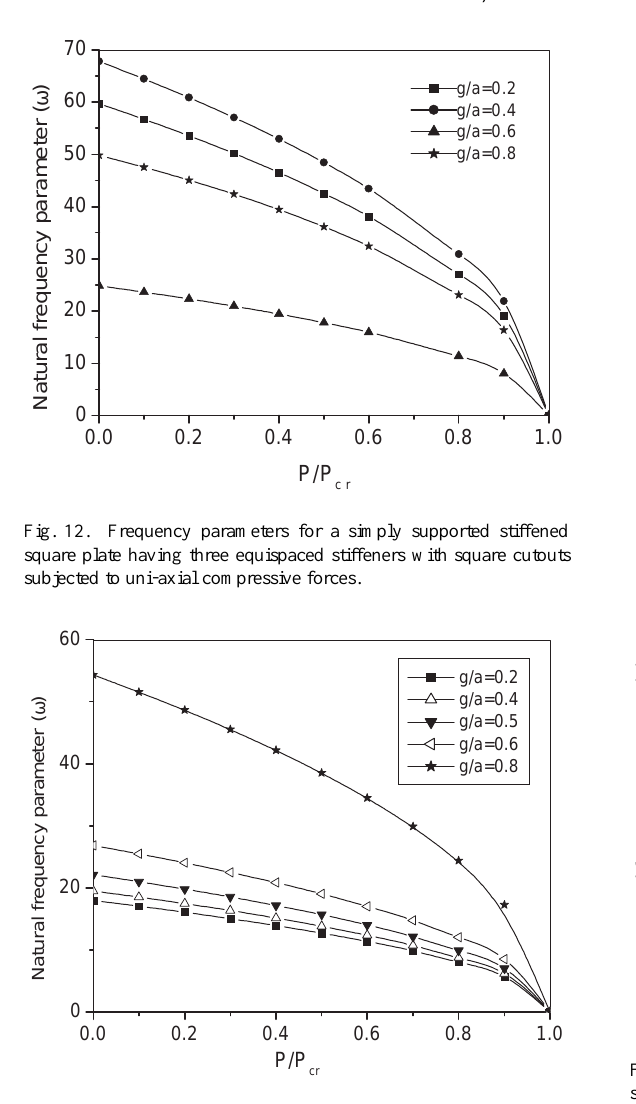
Fig. 13. Frequency parameters for a simply supported stiffened squareplatehavingonecentralstiffenerwithsquarecutoutssubjected to bi-axial compressive forces.